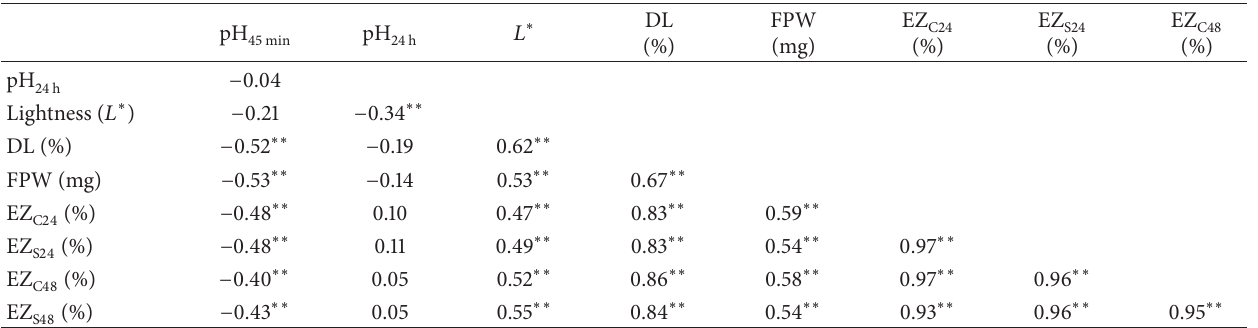
Table 2: Correlation coefficients among the pork loin ( Longissimus thoracis muscle; n = 60) quality